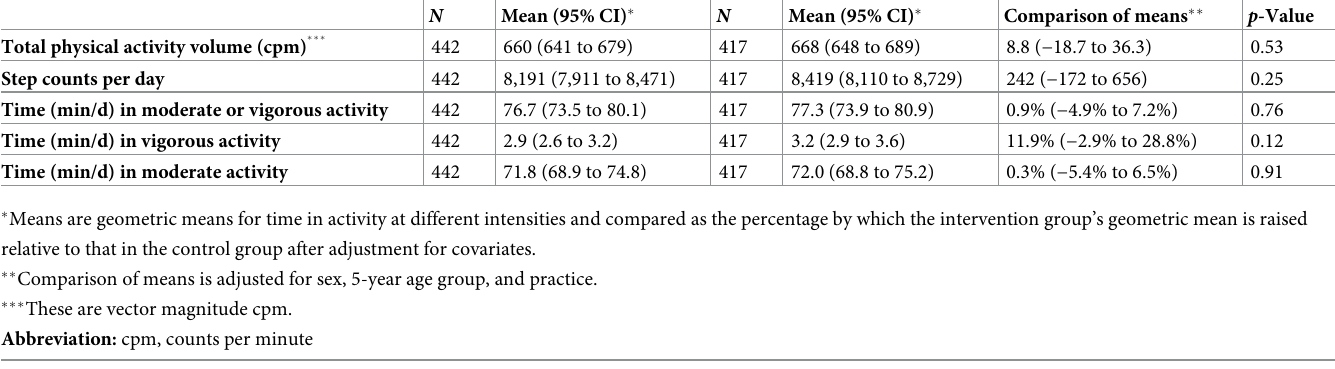
Table 2. Objectively measured physical activity by trial group and between-group differences at 3-month follow-up. Variable